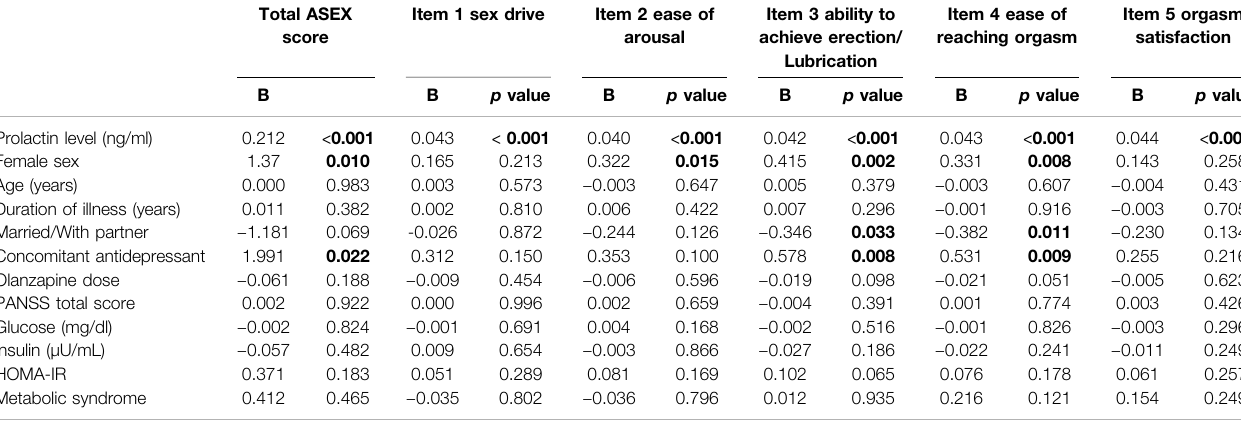
TABLE 5 | Multiple linear regression analysis with individual ASEX item scores as dependent